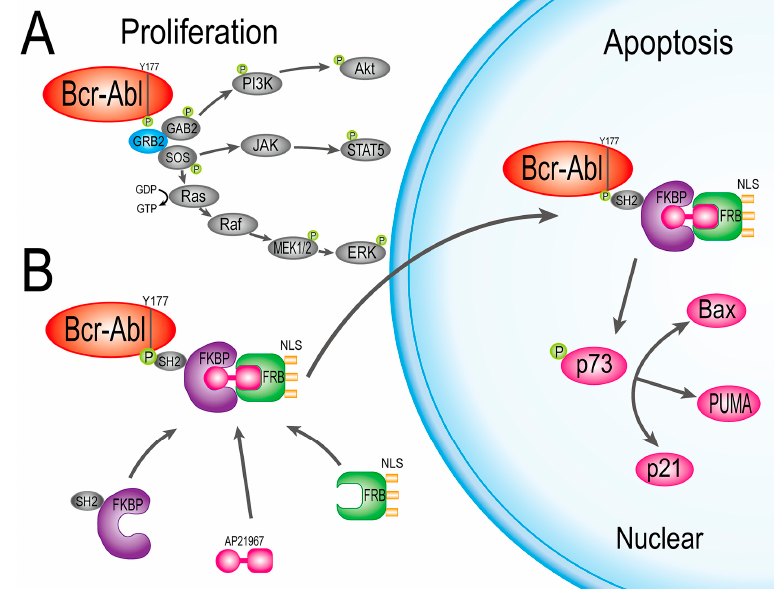
Figure 6. Work model of transporting Bcr-Abl to nucleus: ( A ) normally, Bcr-Abl was located in the cytoplasm, and activated proliferation signaling, such as Janus Kinase/Signal transducer and activator of transcription (JAK/STAT), PI3K/Akt, RAS/MAPK; ( B ) in addition of AP21967, FKBP fused with SH2 and FRB combined with NLS (nuclear localization signals) formed complex, which binded to Bcr-Abl and transported it into nucleus. Firstly, the specificity of affinity between Bcr-Abl and SH2 disturbed the cytoplasmic proliferation signaling though competitively blocking the interaction between Bcr-Abl and Grb2; Secondly, the nuclear Bcr-Abl activated p73 and induced cell apoptosis through the functional domain of Abl.